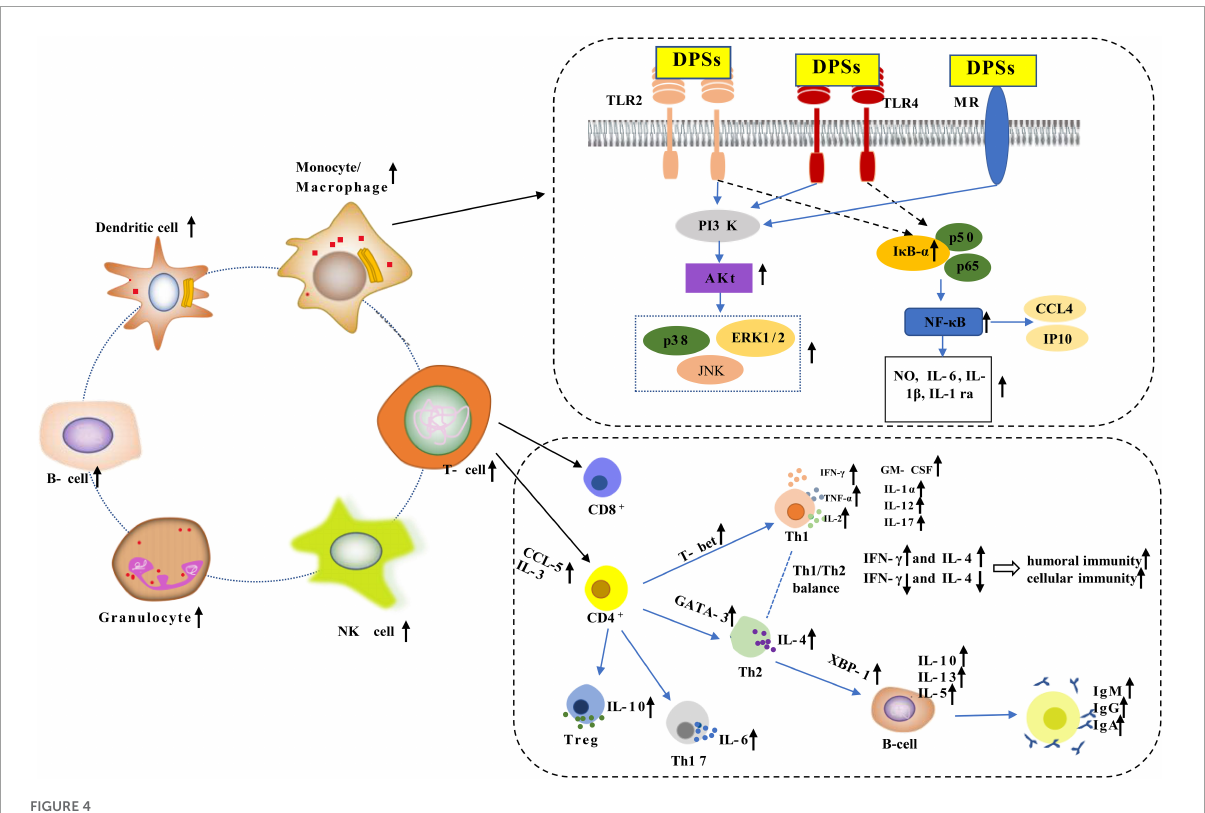
FIGURE4 The potential immunomodulatory mechanisms of D. officinale